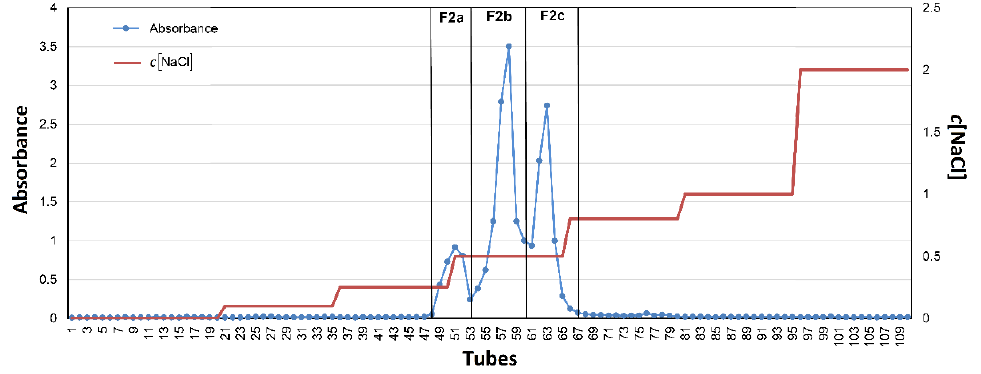
Figure 3. Anion exchange preparative chromatography of F2 . Table 5. Preparative chromatography of F2 .